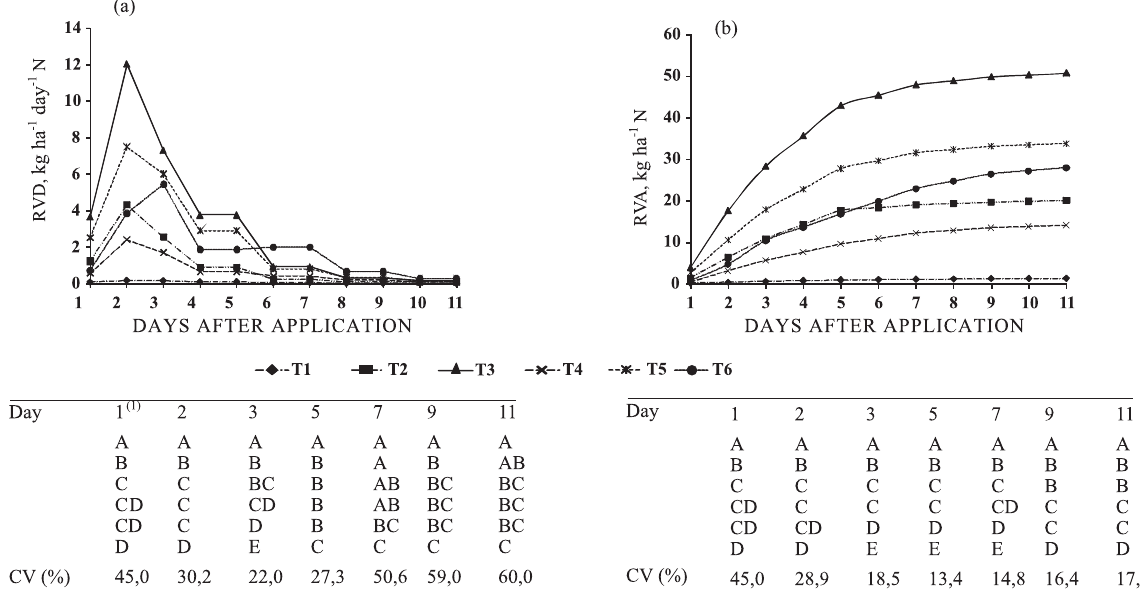
Figure 5. Sum of the two side-dressing fertilizations in N-NH Accumulated Volatilization Rate (AVR) (b) based on the treatments